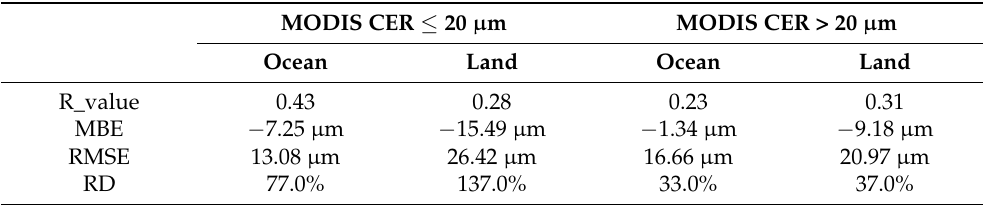
Figure 3. Comparison between MODIS and SGLI for ( a ) COT over ocean, ( b ) CER over ocean, ( c ) COT over land, and ( d ) CER over land for ice cloud pixels. Table 3. Metrics for CER comparisons of ice clouds corresponding to data with MODIS CER ≤ 20 µ m and MODIS CER > 20 µ